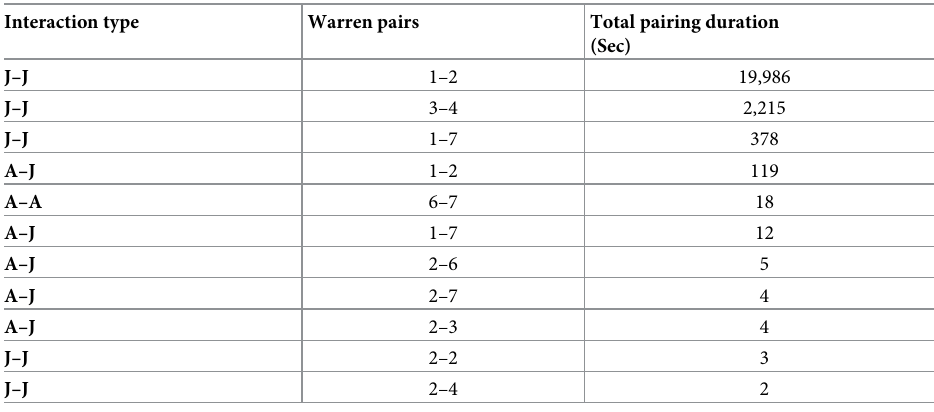
Table 1. Total duration of pairings between pairs of rabbit warrens for three pairs of rabbit age class (J– J = juvenile-juvenile, A–J = adult-juvenile and A–A =